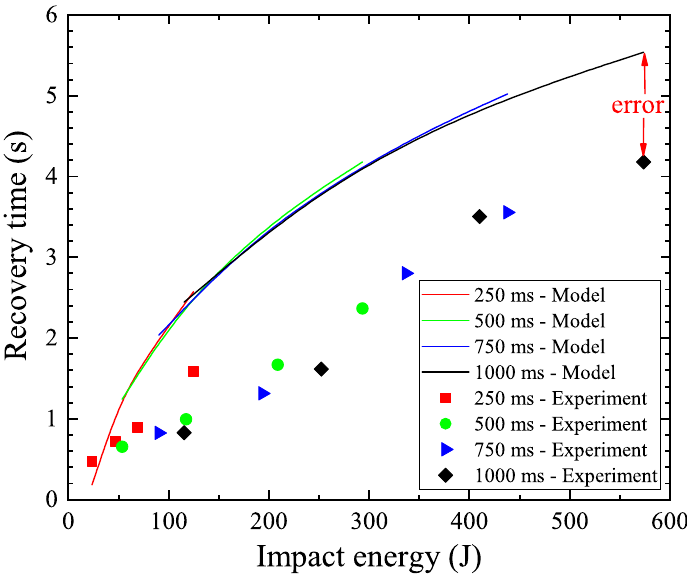
Figure 9. Calculated recovery time compared with the experimental results. Lines and dotted lines represent the calculated and experimental results, respectively. The recovery time is calculated from impact energy throughout the quench and recovery